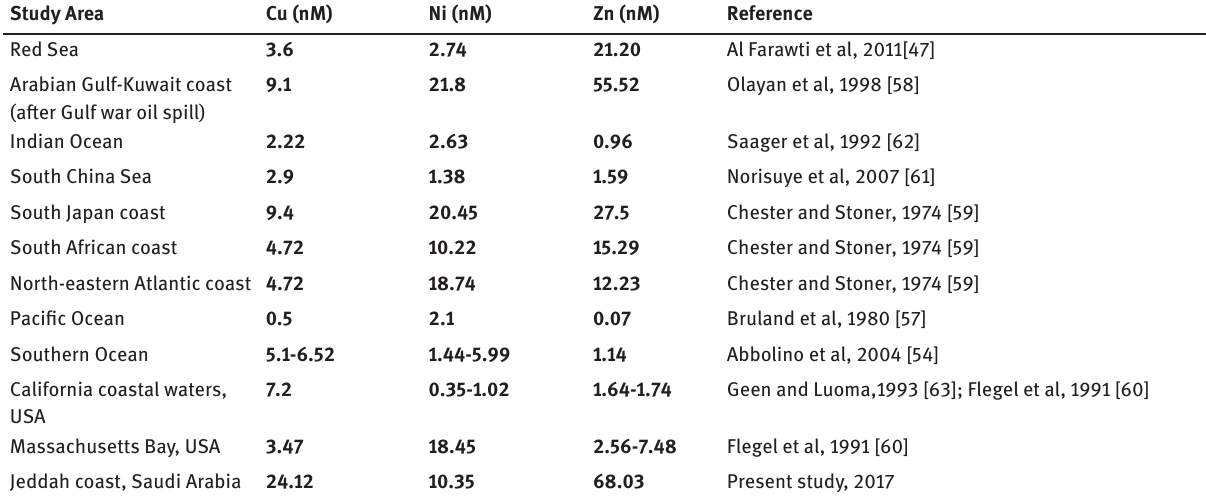
Figure 8: Cross-section profile (a) and surface distribution (b)of dissolved Zn. Table 2: Comparative study of average Cu, Ni, and Zn levels in the surface water of world oceans. Study